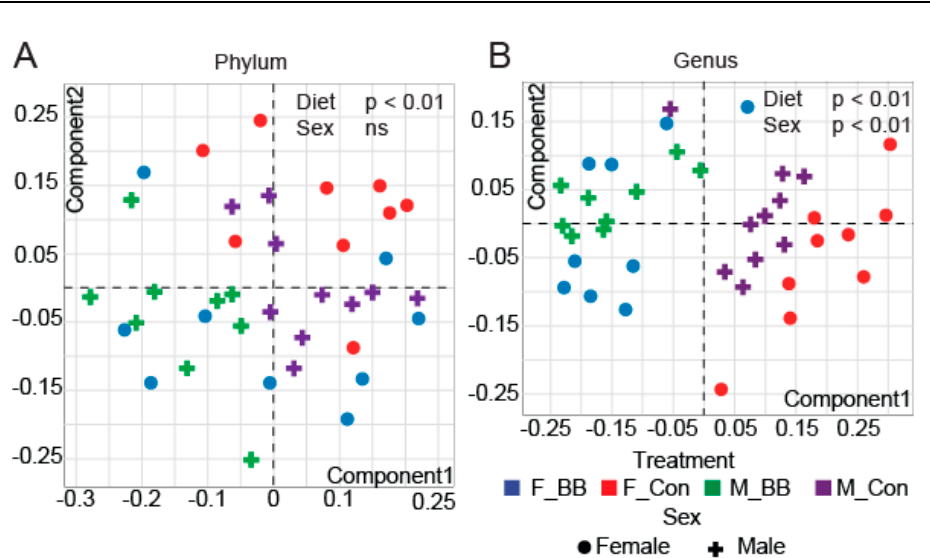
Figure 2. The β -diversity of microbial ecology upon blueberry supplementation. Non-metric multi-dimensional scaling (NMDS) analysis of the operational taxonomical unit (OTU) abundance matrix of the β -diversity of gut microbial communities shows differences at both the ( A ) phylum and ( B ) genus level. (F-BB (female mice fed a blueberry diet) ( n = 9), F-Con (female mice fed a control diet) ( n = 7), M-BB (male mice fed a blueberry diet) ( n = 9), and M-Con (male mice fed a control diet) ( n = 10). Multi-factor ANOVA analysis was performed using an R-based Shiny app (DAME). Sex and diet were used as two factors to determine the significance (ns = non-significant).